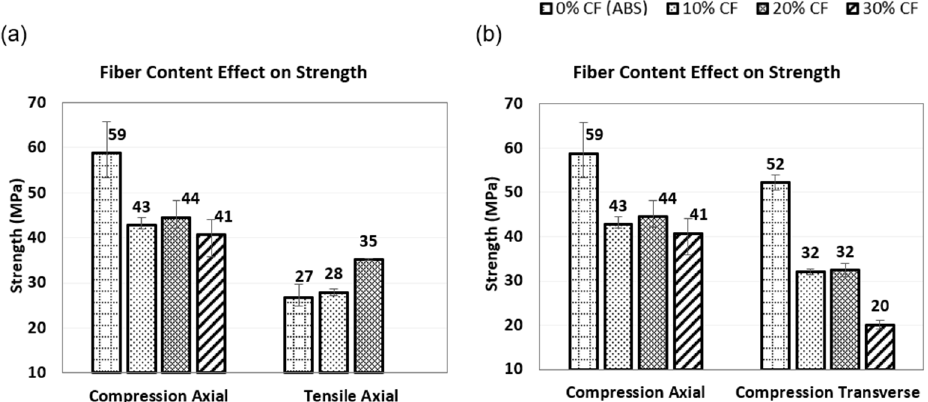
Figure 4 . Fiber Content Effect on the Compressive Strength of AM Fabricated CFRP Composites ( a ) Axial versus Transverse Compression ( b ) Axial Compression versus Axial Tensile .